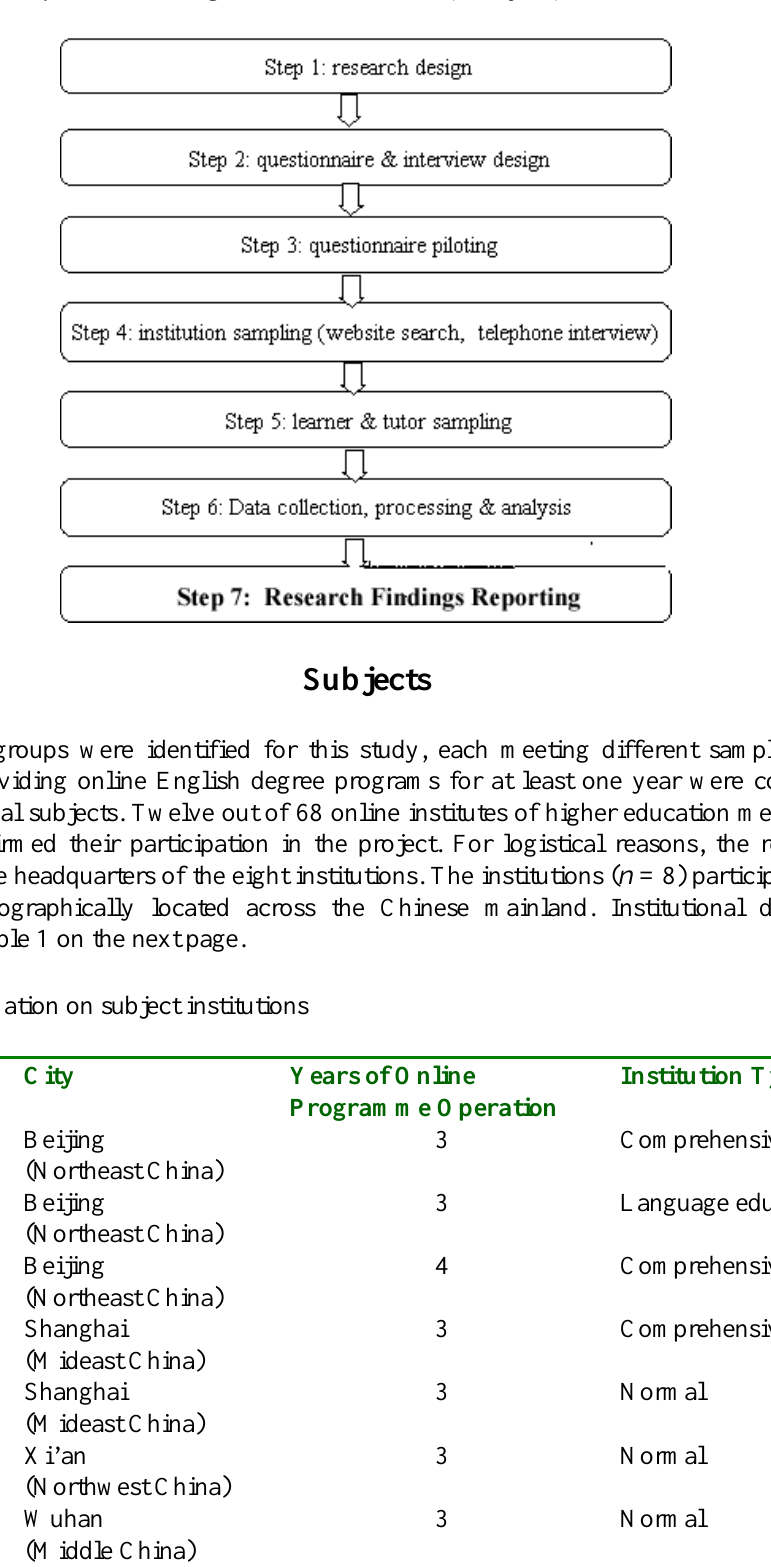
Figure 1. Seven step research design and data collection, analysis, and dissemination procedure